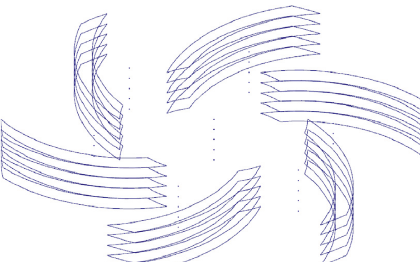
Figure 24: Toolpath for the deposition of the impeller blades with embedded substrate